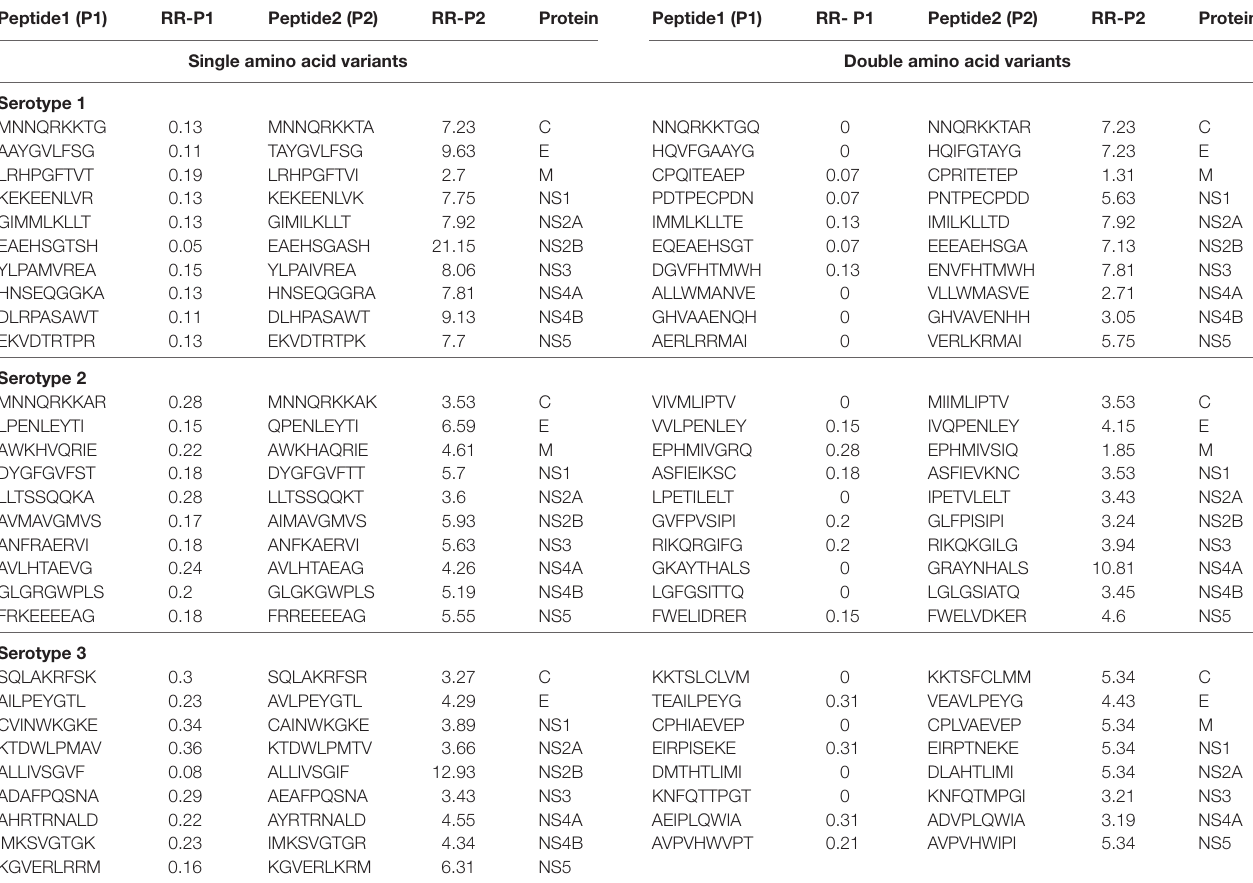
TaBle 1 | Peptides/patterns and their variant (single and double amino acid), associated significantly with dengue fever and dengue hemorrhagic fever (only most differing peptides per protein are shown). Peptide1 (P1) rr-P1 Protein single amino acid variants Double amino acid variants serotype 1